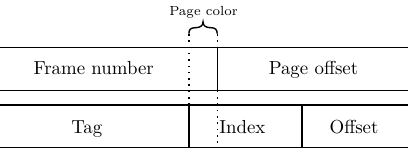
Figure 4: Physical-to-cache address translation in physically indexed caches